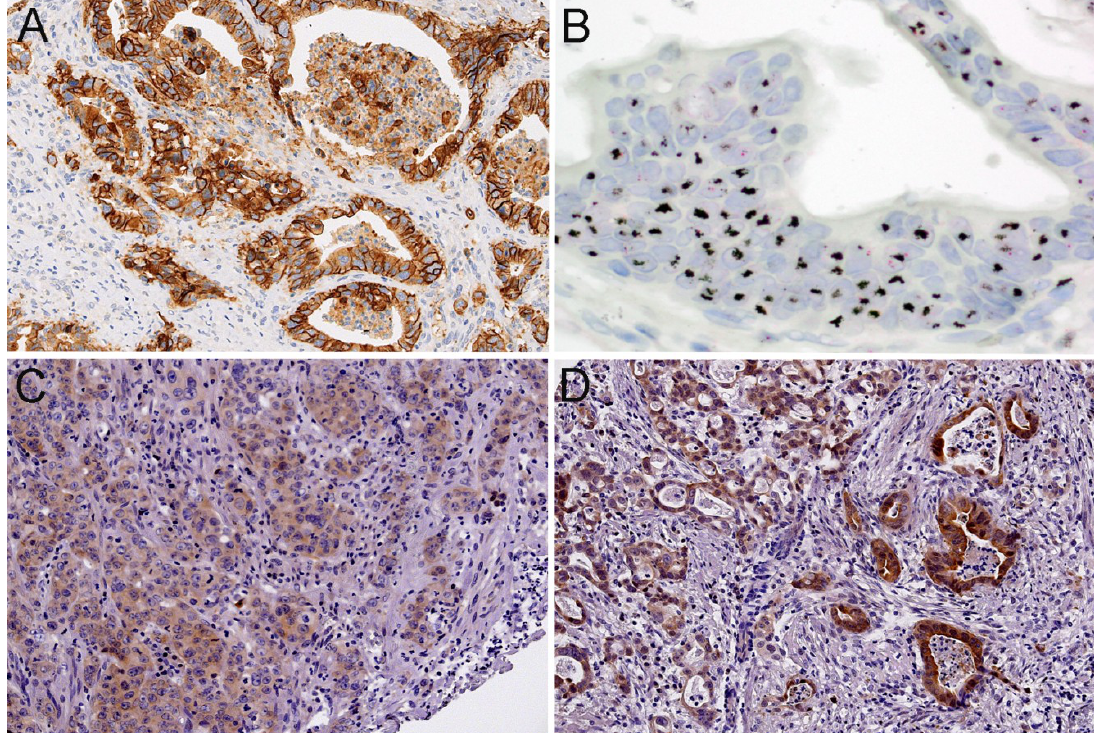
Figure 1. Examples of immunohistochemical stainings and in-situ hybridization: ( A ) Her2 immunohistochemistry 3+ (positive) ×20; ( B ) Her2 high level amplification by silver in situ hybridization/SISH ×40; ( C ) HSP90 immunohistochemical low expression ×20; ( D ) HSP90 immunohistochemical high expression;